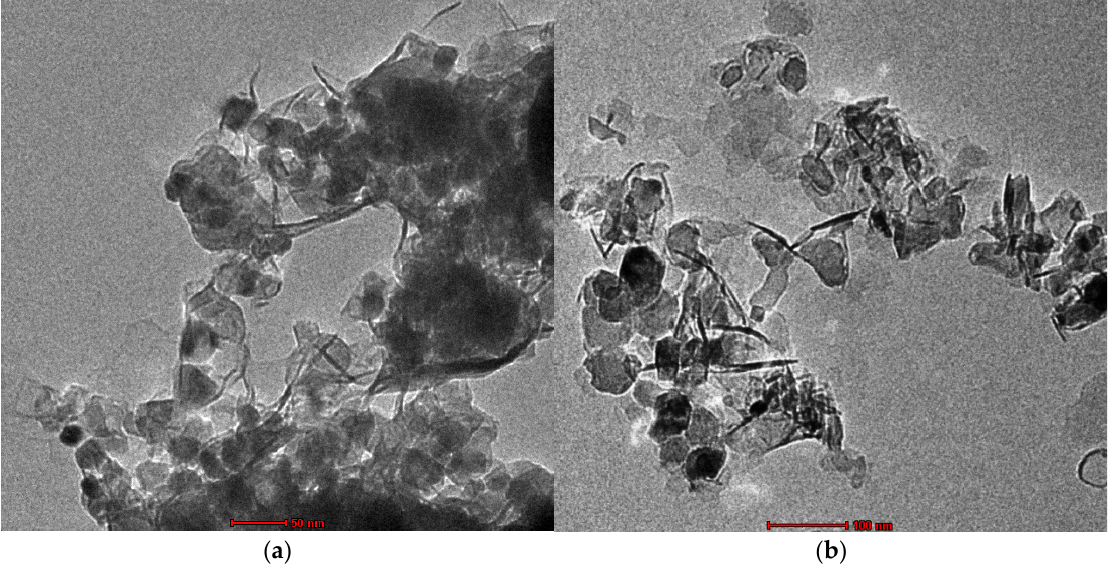
Figure 4. TEM images of ( a ) Zn50Mg50O and ( b ) G-Zn 50 Mg 50 O.